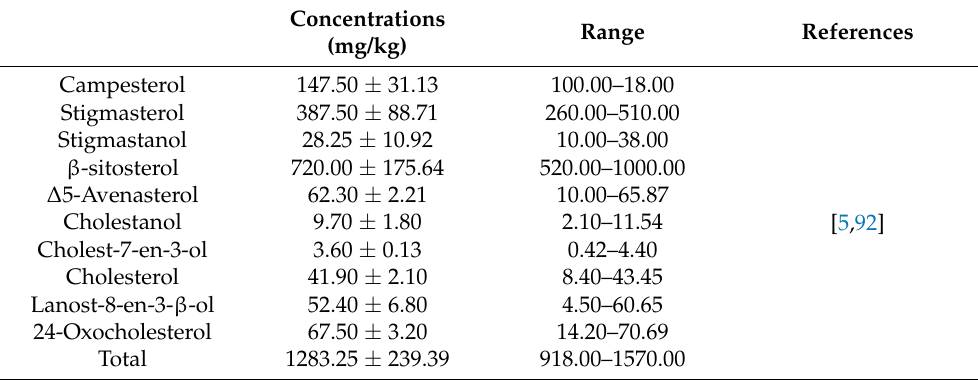
Table 7. Sterol contents in